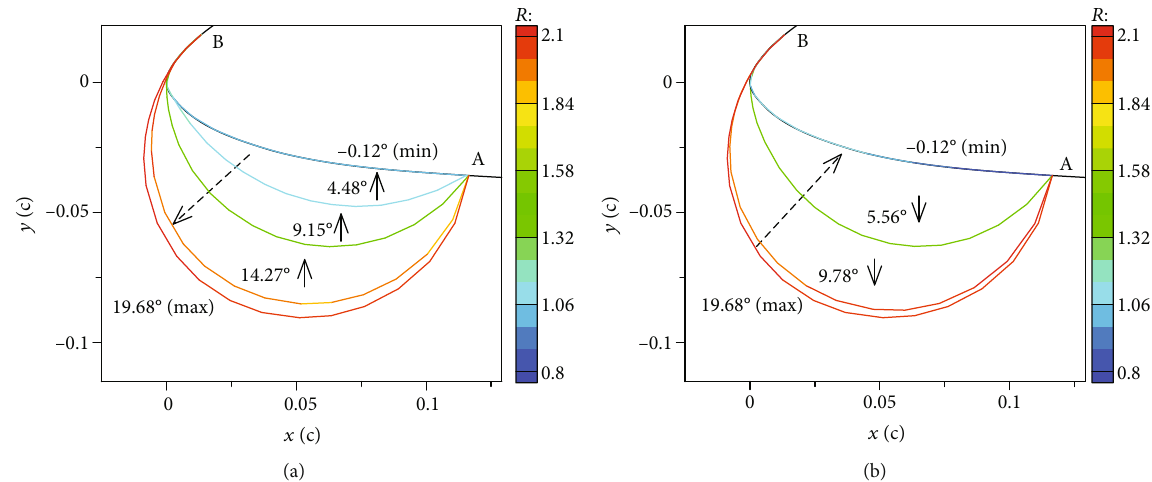
Figure 11: ILE shapes and change in the tension at di ff erent angles of attack during a pitching cycle in airfoil frame of reference: (a) upstroke phase and (b) downstroke phase.